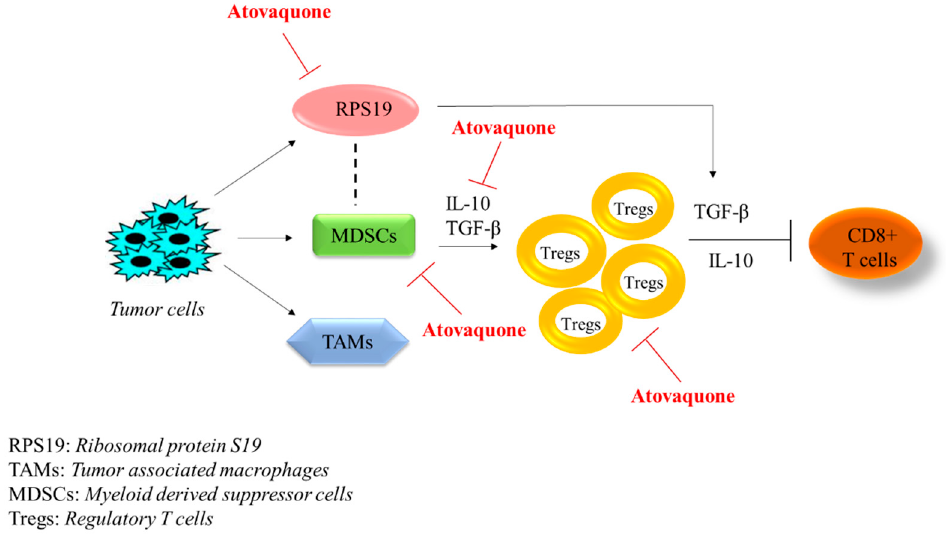
Figure 6. Schematic diagram depicting the role of atovaquone in immune system. Tumors secrete various factors which promote the accumulation of heterogeneous population of TAMs, MDSCs and immunosuppressive protein RPS19 in the tumor microenvironment. MDSCs induce Tregs’ activation by the production of IL-10 and TGF- β . Furthermore, Tregs suppress CD8+ cytotoxic T cells’ function through secretion of IL-10 or TGF- β from Tregs and tumors. The dotted line in Figure 6 indicates the interaction between RPS19 and MDSCs in tumor microenvironment that induces the production of immunosuppressive cytokines, including TGF- β . Atovaquone (ATQ) reduces the expression of RPS19, MDSCs, Tregs and immunosuppressive cytokines IL-10 and TGF- β in tumor cells .